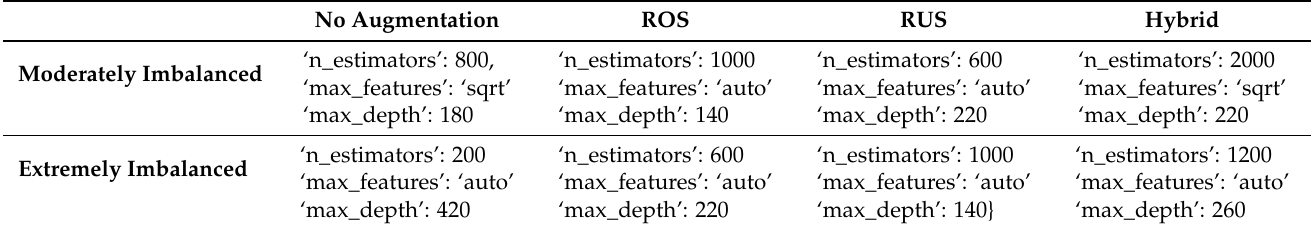
Table 3. Optimal hyperparameter values for each condition from randomized grid